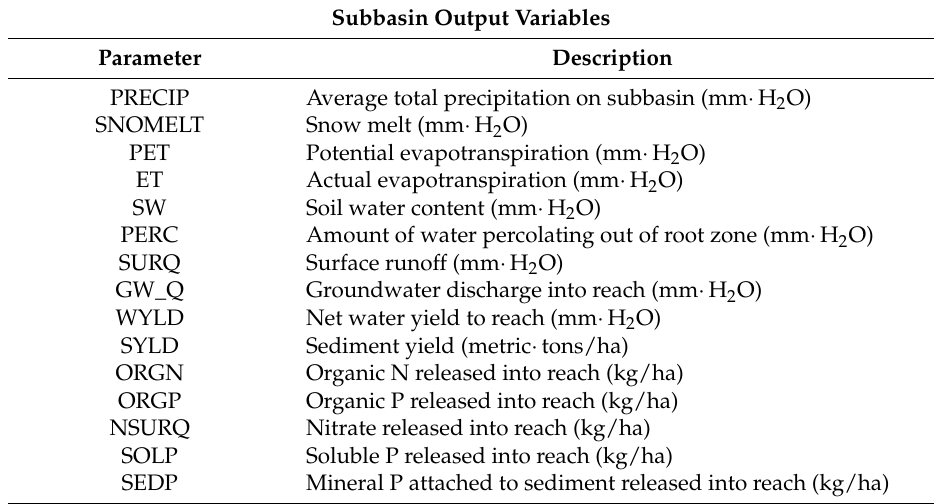
Table C2. Printable SWAT variables for subbasin outputs.